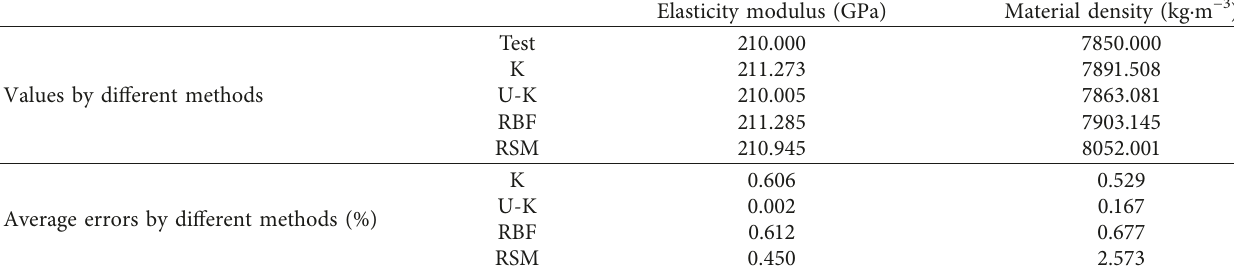
Table 2: Parameters and errors of model updating.